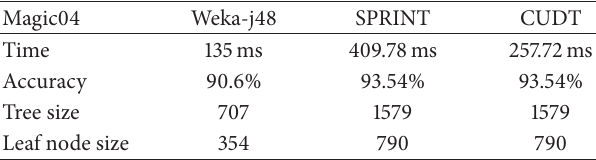
Table 3: Results of Magic04.